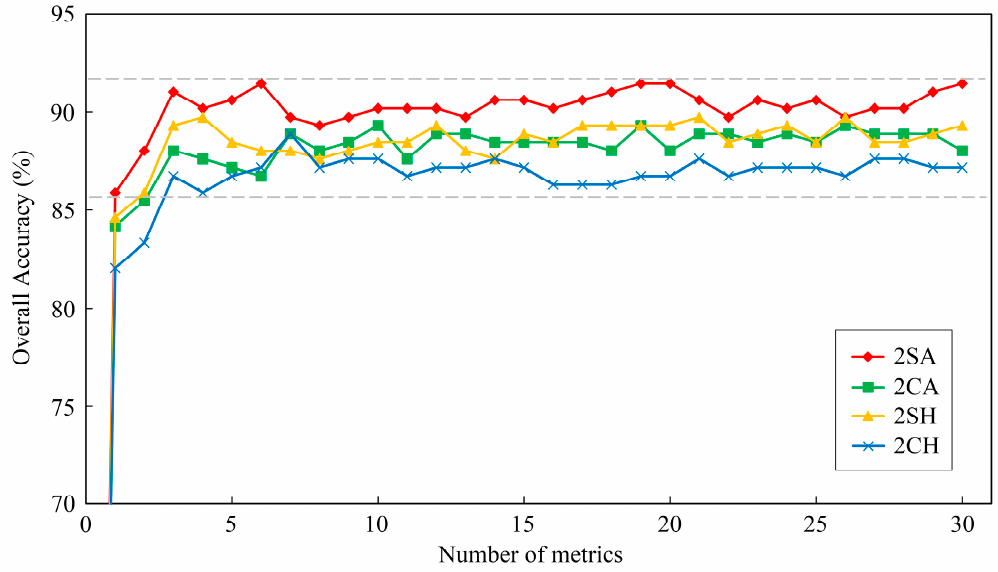
Figure 8. Evolution of overall classification accuracy with changing number of metrics. 2SA = Two forest-types classification using all metrics (LiDAR and sunlit hyperspectral metrics); 2CA = Two forest-types classification using all metrics (LiDAR and crown hyperspectral metrics); 2SH = Two forest-types classification using sunlit hyperspectral metrics; 2CH = Two forest-types classification using crown hyperspectral metrics. Table 6. The six most important metrics from random forest for classifying tree-species ranked high to low according to the mean decrease in Gini index.